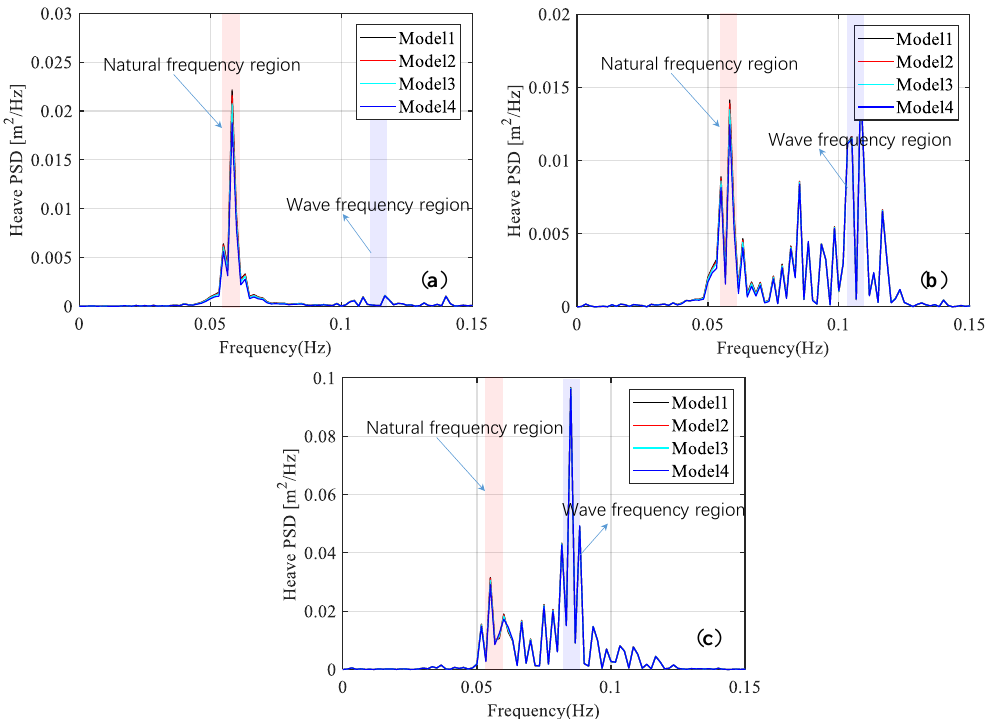
Figure 11. Frequency domain curves of the surge PSD of the multi-segmented mooring line models: ( a ) LC4; ( b ) LC5; and ( c ) LC6.